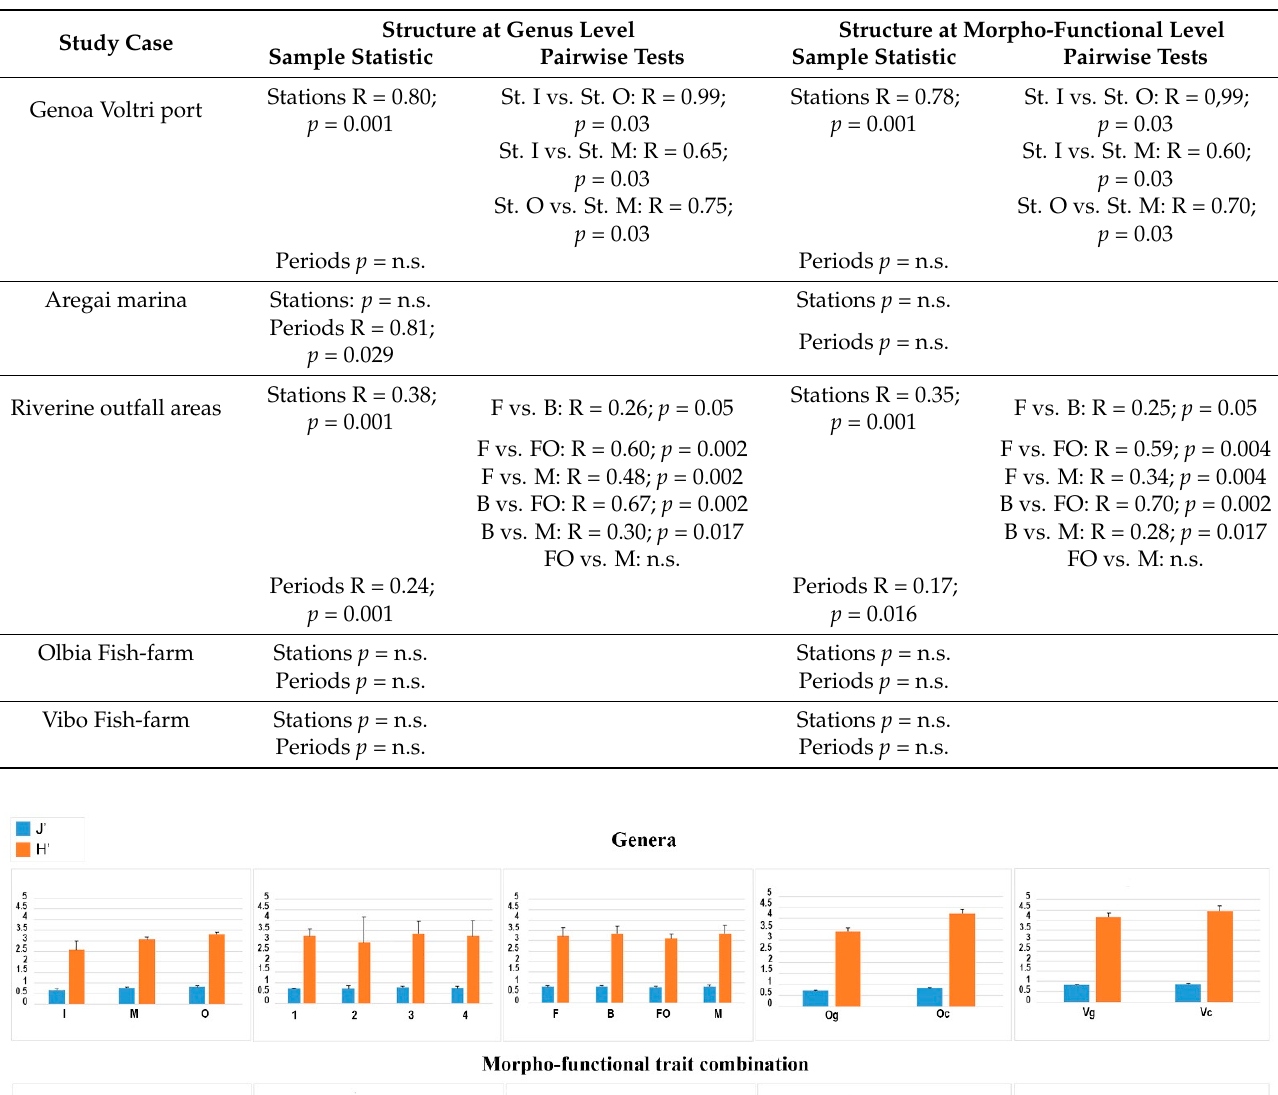
Table 1. Results of Analysis of Similarities (ANOSIM) performed to detect the presence of signifi- cant differences among the stations and sampling periods of each study case (n.s. indicates when significant differences were not found).